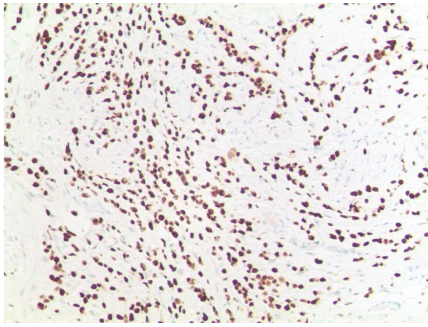
Figure 3: Positive immunohistochemical staining for